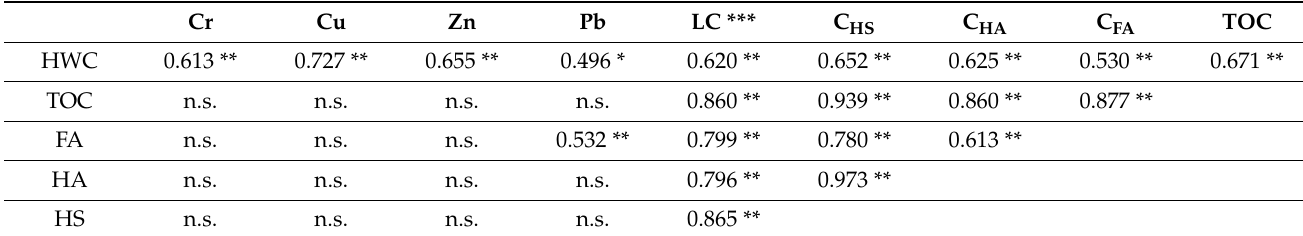
Table 5. Simple correlation coefficient.